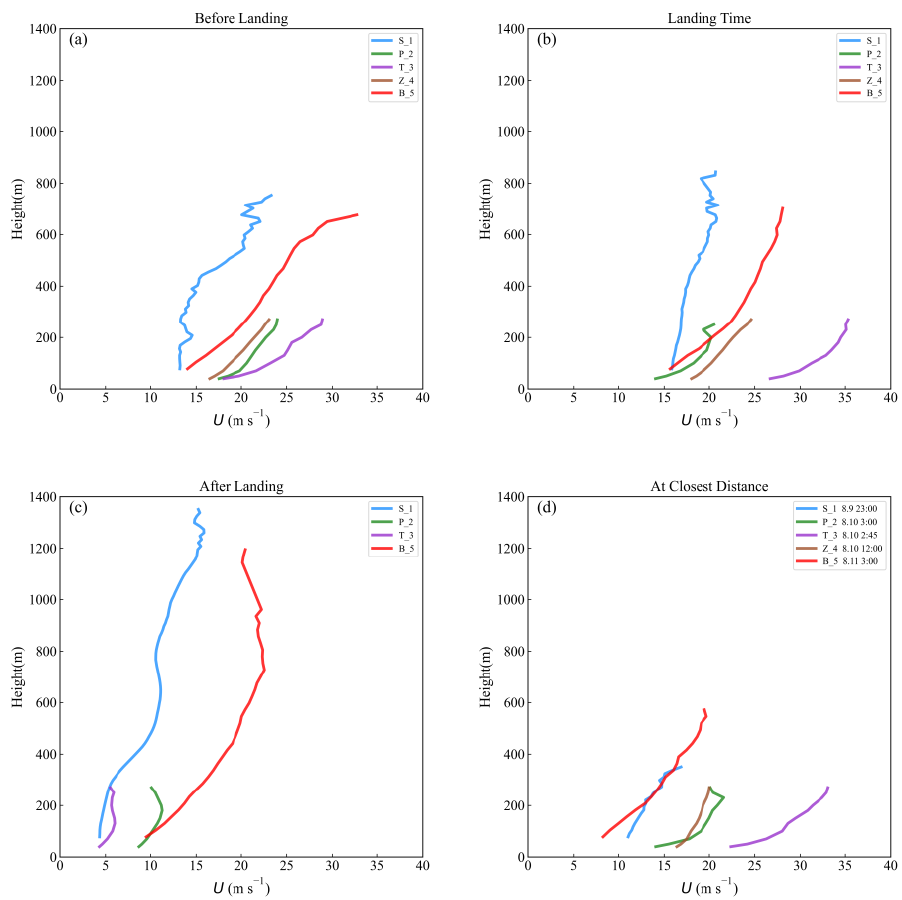
Figure 6. Variation of U with height for DWLs at different moments of the typhoon. ( a ) at 8 h before typhoon landfall, ( b ) at the moment of landfall, ( c ) at 8 h after typhoon landfall, ( d ) at the closest distance to the typhoon center.